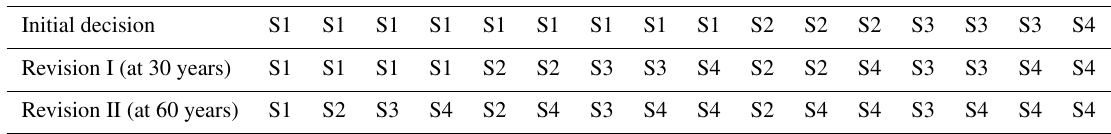
Table 6. Potential protection strategies for Rosenheim implemented over the measure life time. Protection system S1 corresponds to the current protection whereas system S4 corresponds to the current protection plus 1m heightening of dikes and walls plus a flood polder (retention basin). Lowering the protection is not